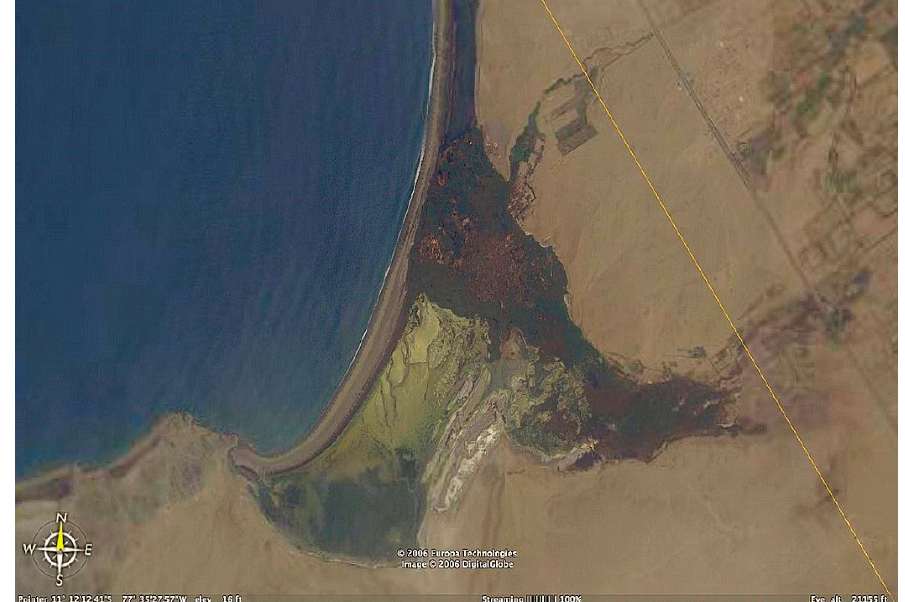
Figure 27. Google Earth satellite photograph of a part of the Medio Mundo beach ridge and infilled marsh area behind the ridge in the Supe Valley coastal area that limits river flows to the ocean. A ridge of this magnitude results from a catastrophic El Niño event (or closely spaced events) and subsequently alters the deposition placement of subsequent El Niño-derived beach ridge placements in different sections of the Peru coastline.